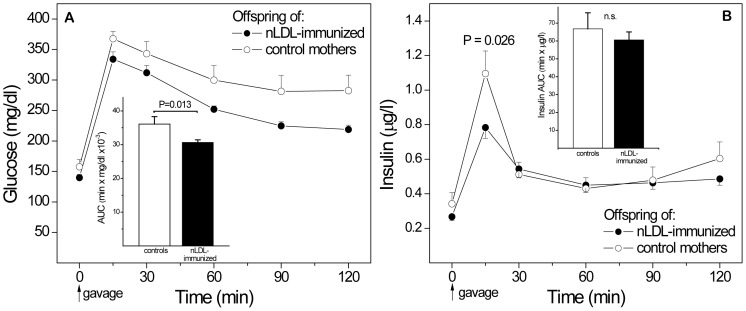
Protective effects of maternal immunization with naturally oxidized LDL (nLDL) on male offspring fed 0.5% cholesterol diet.(A) Glucose response in an OGTT in offspring after 29 weeks on diet. (B) Insulin responses in the same OGTT. AUCs for glucose and insulin are shown as insets; statistical significances for individual time points are not indicated. n = 26.